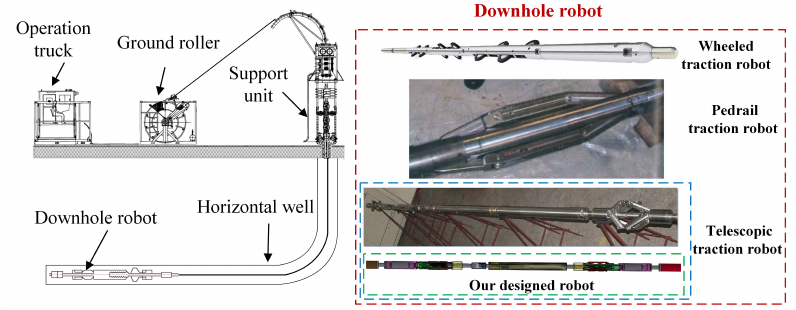
Figure 1. Brief introduction of the downhole robot